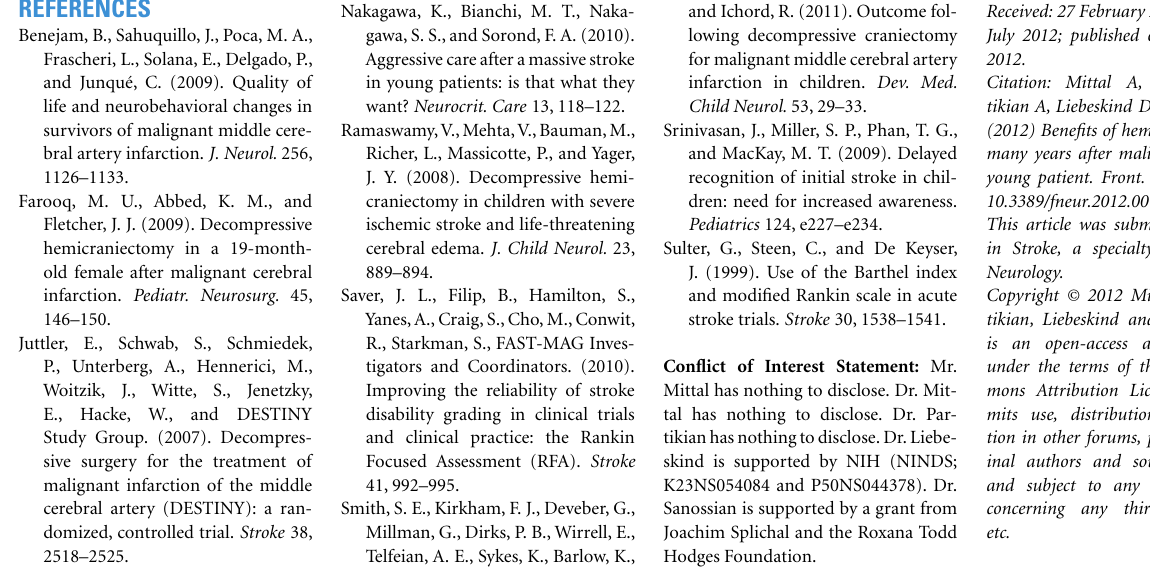
carotid artery distal to the bifurcation (B) and non-contrast head CT scan performed post-hemicraniectomy demonstrating large area of hypodensity in the right middle cerebral territory with mass effect